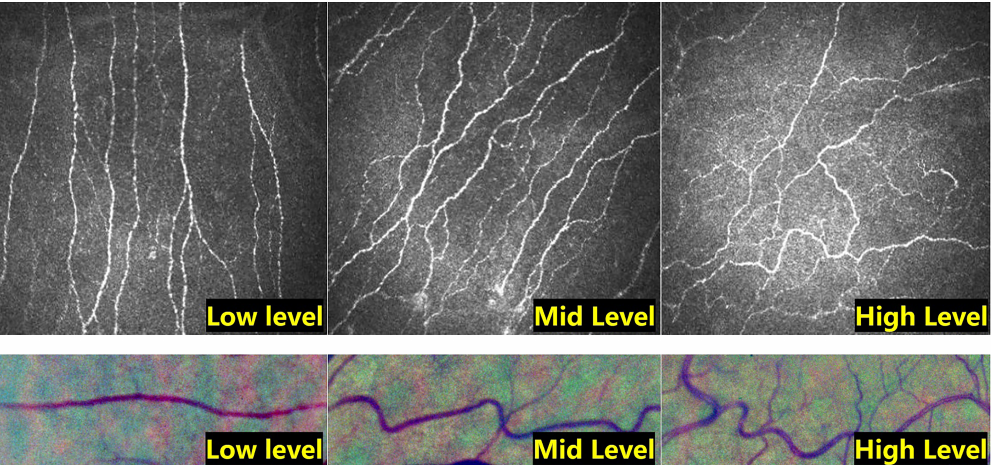
Figure 1. Corneal nerve fibers ( top ) and retinal vessels ( bottom ) with low, middle and high tortuosity